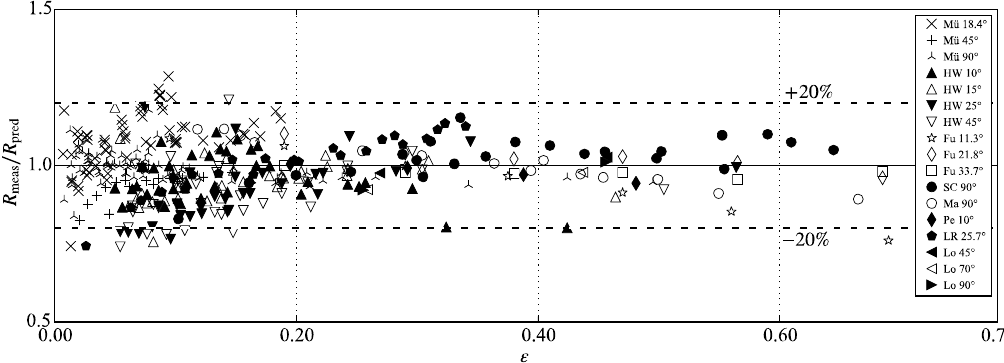
Figure 12. Measured over predicted (Equation (10)) runup height R meas / R pred versus relative wave crest amplitude ε for experiments from data sources from Müller (Mü) [7], Hall and Watts (HW) [14], Fuchs (Fu) [20], Street and Camfield (SC) [21], Maxworthy (Ma) [19], Pedersen et al. (Pe) [27], Li and Raichlen (LR) [28], and Losada et al. (Lo) [29].